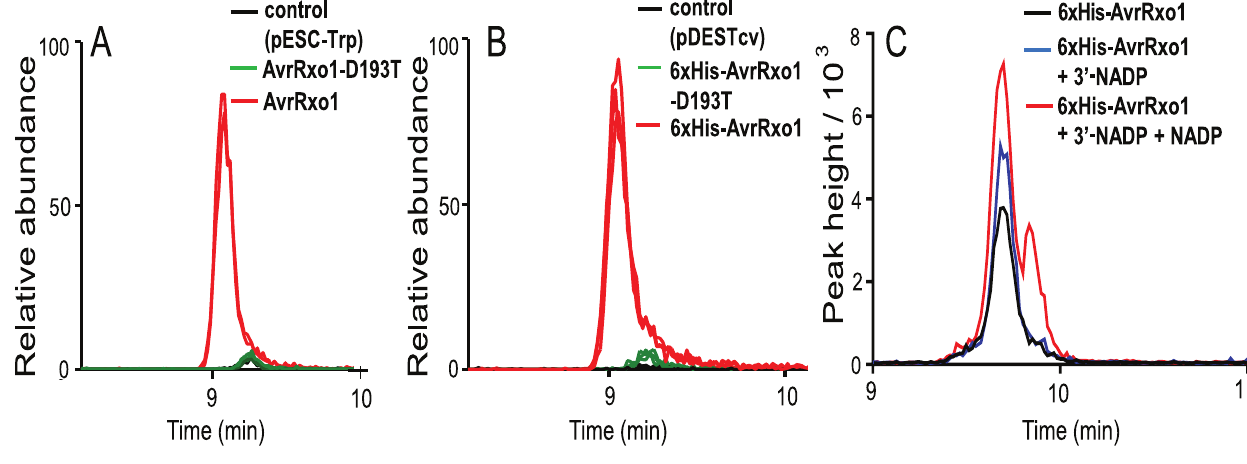
Fig 2. Accumulation of 3’-NADP is the major metabolite change elicited by AvrRxo1expression in E . coli and S . cerevisiae . (A-B) Extracted ion LC- MS chromatograms of the NADP parent ion, m/z 742.067,in negativeion mode in yeast (A) and bacteria(B) expressingeither AvrRxo1, AvrRxo1-D193T, or the relevant control. S . cerevisiae strains analyzedin (A) carried pESC-TRP-DEST-AvrRxo1, -AvrRxo1-D193T, or pESC-TRP. E . coli strains analyzedin (B) carried pDEST-AvrRxo1, pDEST-AvrRxo1-D193T, or pDESTcv. Biological replicates, n = 3, are overlaid.(C) Extracted ion LC-MS chromatogram of NADP in a representative AvrRxo1-expressingbacterial extract from (B), unspiked,spiked with 3’-NADP, or spiked with both 3’-NADPand NADP.